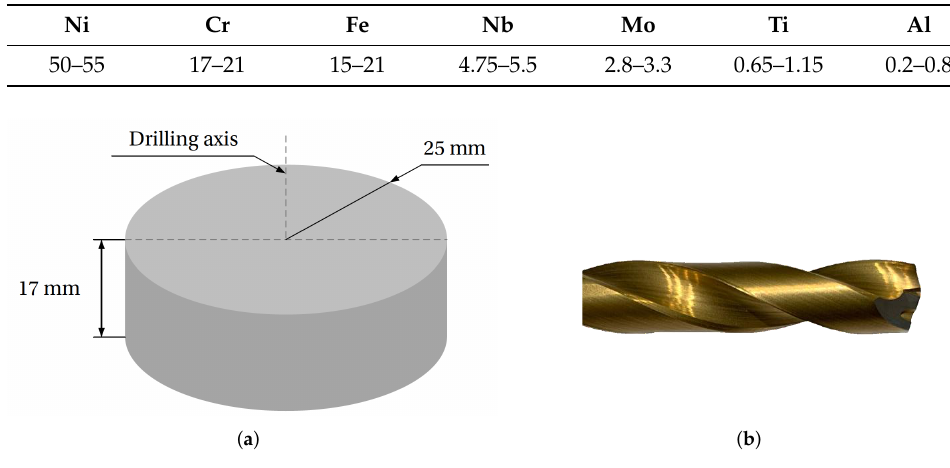
Figure 1. Geometry of experimental tests: ( a ) drilled workpiece; and ( b ) drill